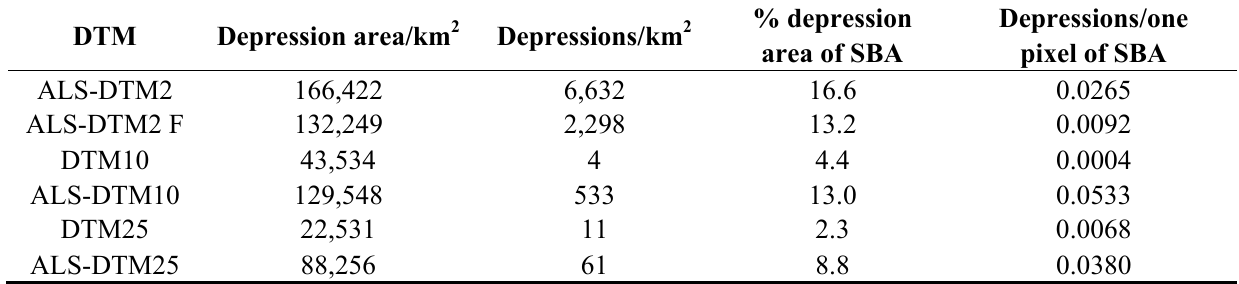
Table 5. Distribution of depressions in Kainastonjoki River study